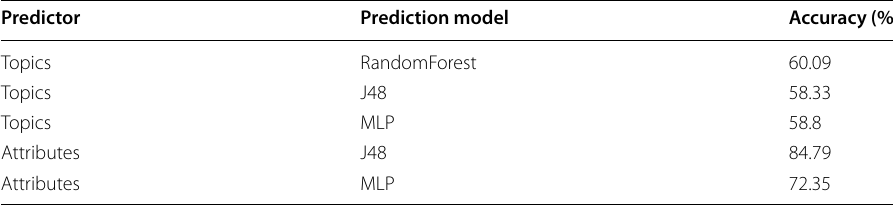
Table 19 Prediction model summary for topics and attributes prediction